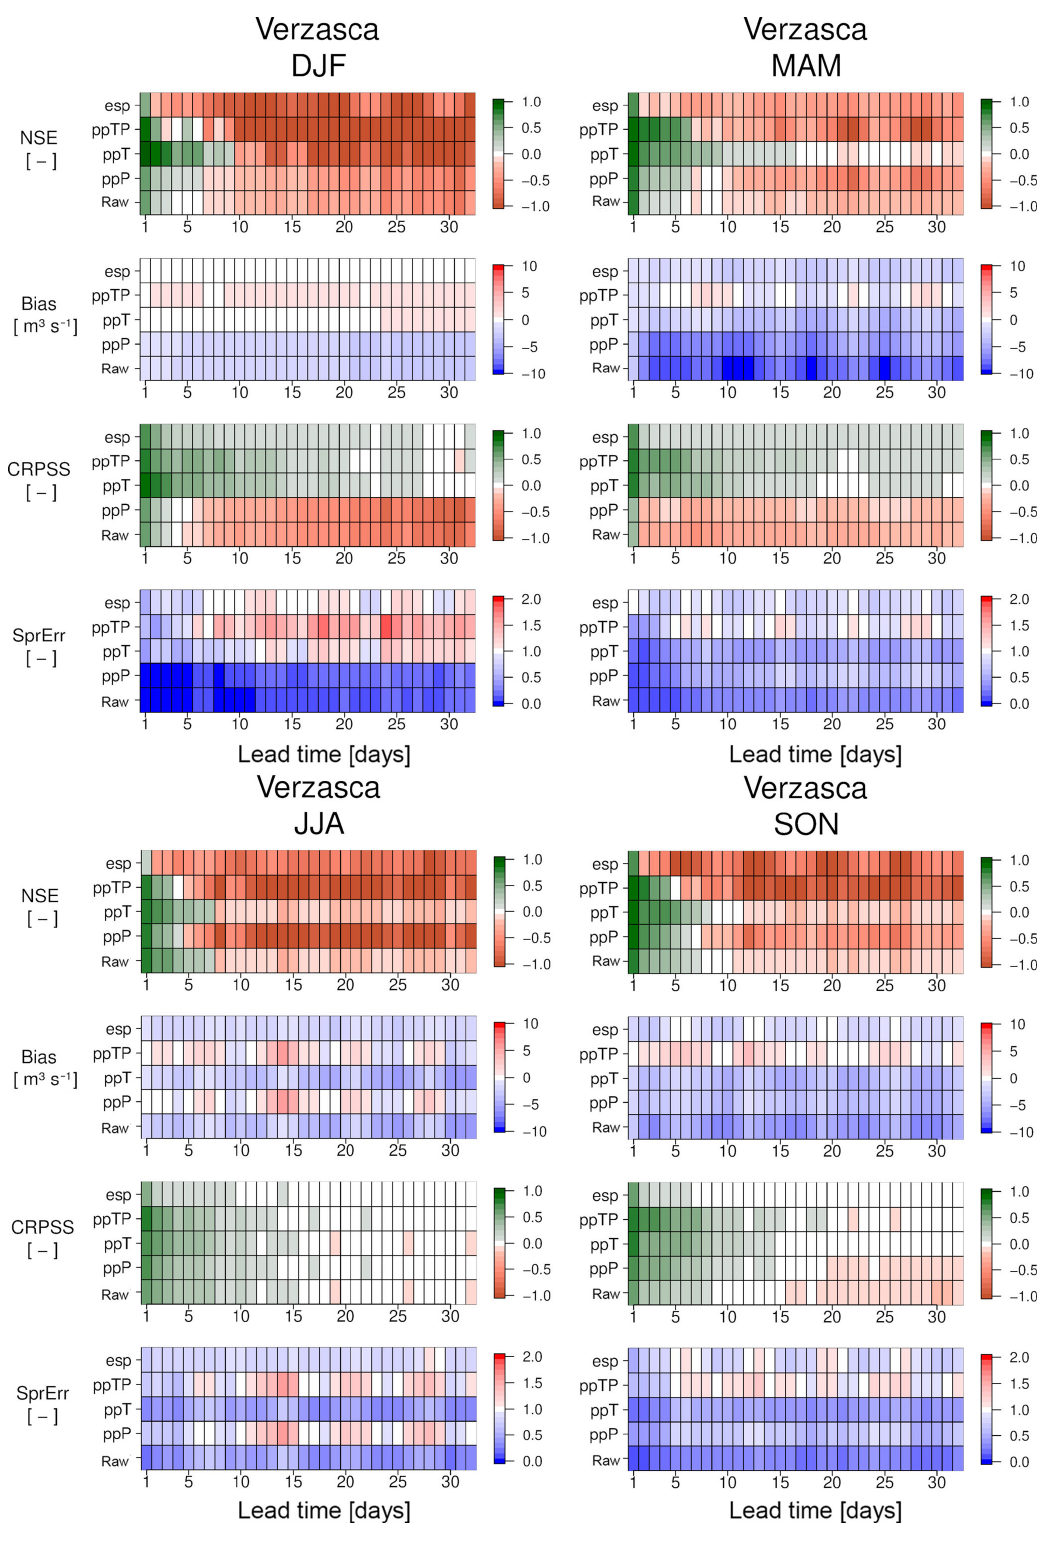
Figure 5. Same as Fig. 4 but seasonally aggregated (DJF, MAM, JJA, and SON) for the Verzasca catchment.